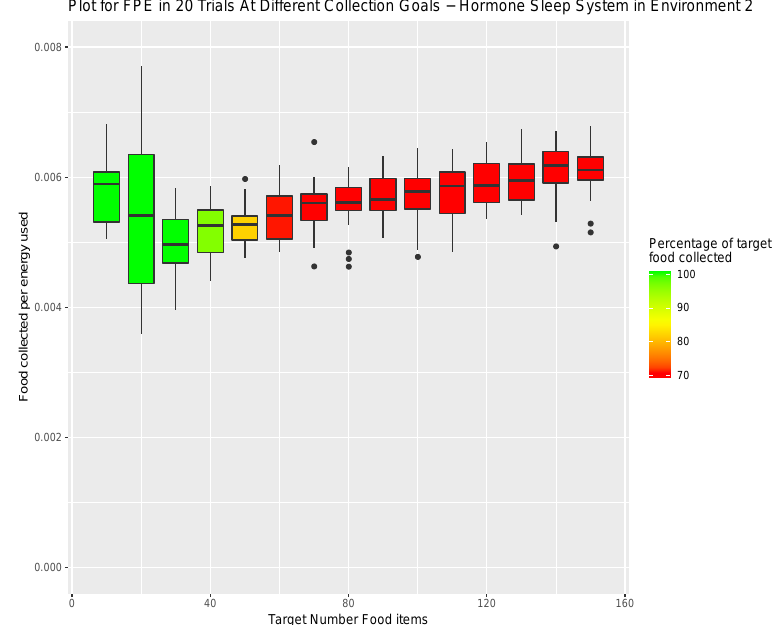
Figure 9. Hormone inspired sleep system tested in environment 2. Target number for items collected ranged from 10 to 150 items of food. Percentage of the items requested versus those collected by the end of the simulation is indicated by colour (Green 100% and Red <